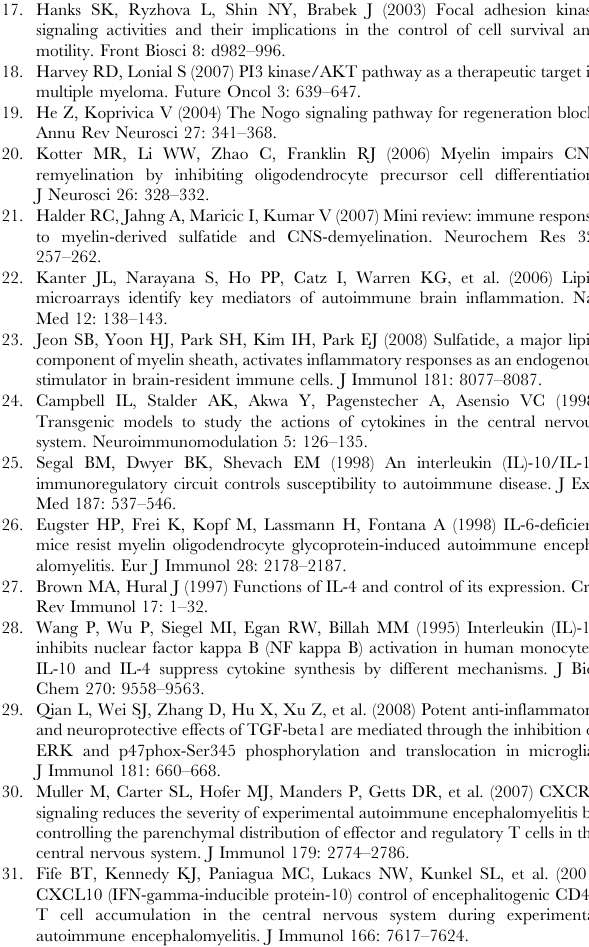
Figure S1 Myelin clearance by macrophages from WT and CR3 KO mice. (A) Bone marrow-derived macrophages from WT and CR3 KO mice were incubated with myelin for 48 hours and cells were stained with Oil Red O and MBP antibody, respectively. (B) In vivo study showed that myelin debris can be phagocytosed by macrophage from WT and CR3 KO mice after spinal cord injury. Representative micrographs of myelin uptake by macro- phage in the injured spinal cord at 2 weeks after injury in WT and CR3 KO mice using confocal microscopy. Macrophage was labeled with IBA-1 (green) and myelin debris was stained by Oil Red O (red). Scale bar= 10 m m. Figure S2 Comparison of myelin uptake by bone marrow- derived macrophages and primary microglia cells. Bone marrow- derived macrophages and primary microglia cells were incubated with myelin for 3 hours. Non-ingested myelin was washed away with PBS and cells were lysed. Intracellular MBP was assessed by ELISA. Data were expressed as mean 6 SEM. (n= 3, *P , 0.05 vs. control; # P , 0.05 vs. microglia cells + Myelin; t